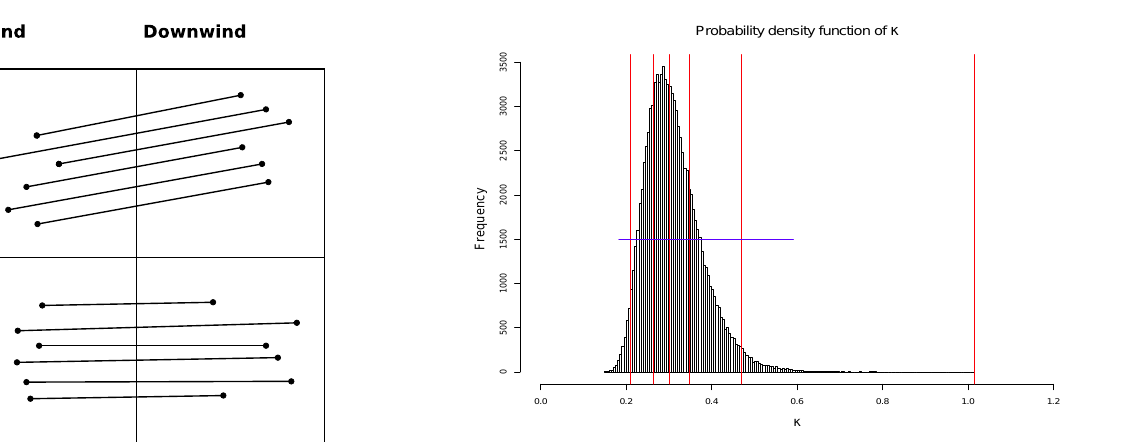
Fig. 3. Hygroscopicity parameter (cid:20) compared for up- and downwind stations during the Full Cloud Events (FCE, left panel) and during Non Cloud Events (NCE, right panel). The error bars represent a maximum absolute error in SS of (cid:6) 0.02% for SS (cid:20) 0 : 2% and a 10% relative uncertainty for SS > 0 : 2% (Gysel and Stratmann, 2013).